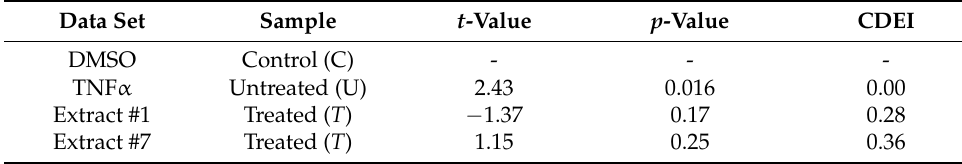
Table 5. CDEI testing